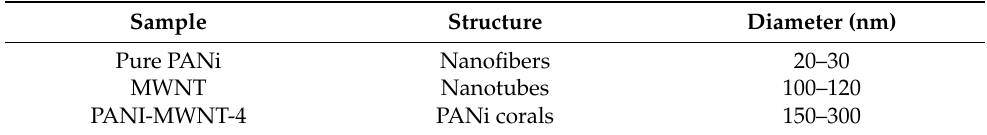
Table 4. The structure and diameter of pure PANi, MWNT, and PANi-MWNT-4 [97]. Sample